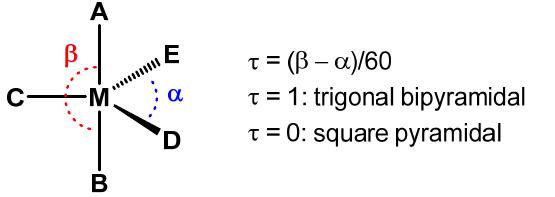
Figure 2. The trigonal bipyramidal geometry with basal angles α and β , and angular structure parameter τ . Table 1. Selected bond lengths [Å] and bond angles [°].